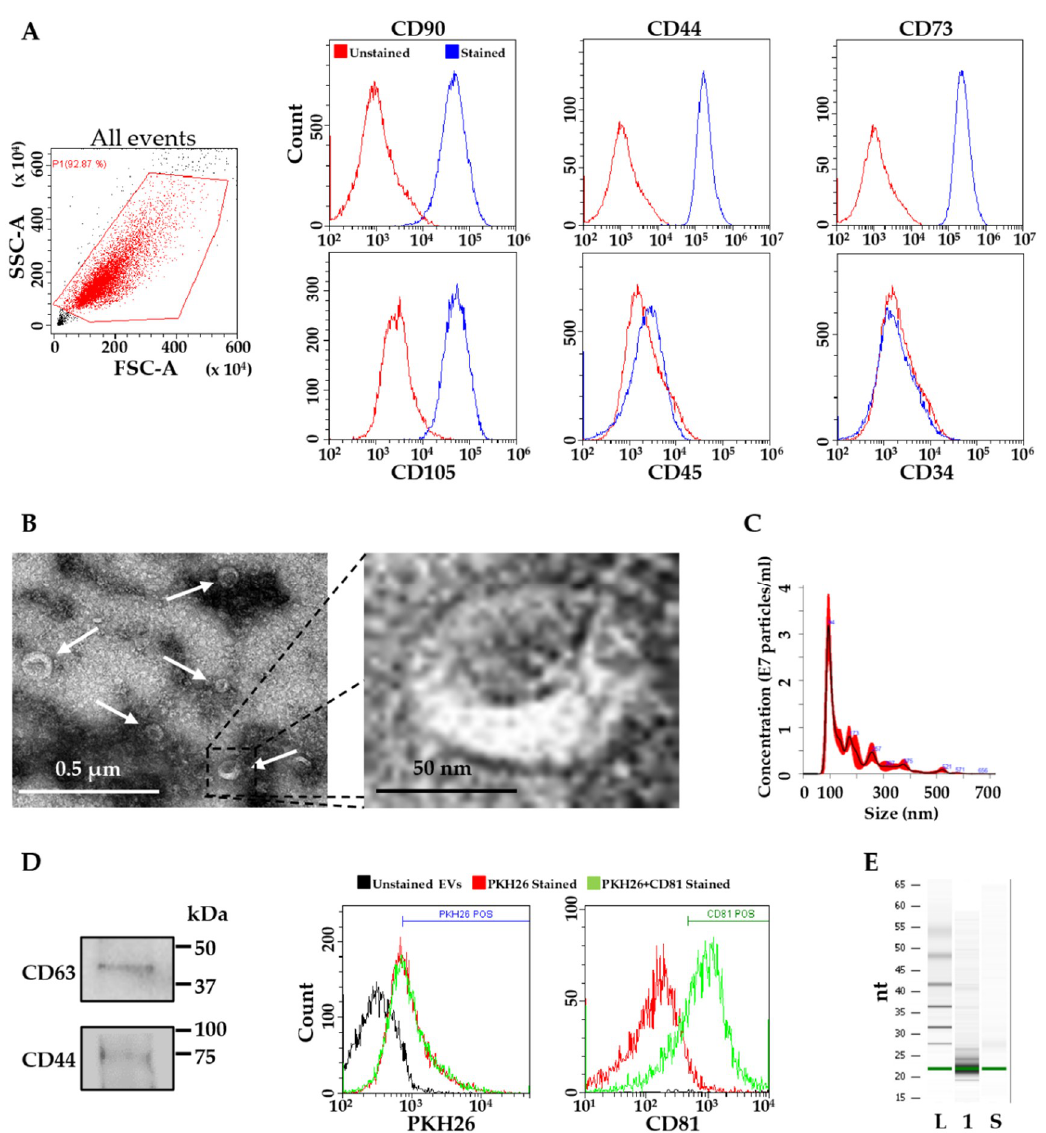
Figure 1. Characterization of ASCs and ASC-EVs. ( A ) Flow cytometry analysis of mesenchymal positive (CD90, CD44, CD73 and CD105) / negative (CD45) and hematopoietic (CD34) stem cell markers confirming ASC identity. Representative plots of ASC1 are shown; ( B ) Electron microscopy of ASC-EVs (white arrows in negative-stain images) with 10 × magnification of a representative EV field; ( C ) Representative nanotracking analysis of EVs; ( D ) Western blot showing the presence of EV (CD63) and MSC (CD44) markers on ASC-EVs and flow cytometry scoring CD81 EV marker positivity on PKH26-labeled ASC-EVs; ( E ) Representative Bioanalyzer profiles of ASC-EVs, the small RNAs corresponding to 20–25 nt were dominant. L stands for Ladder, 1 for RNA extracted from ASC1-EVs and S for synthetic 22 nt small RNA.